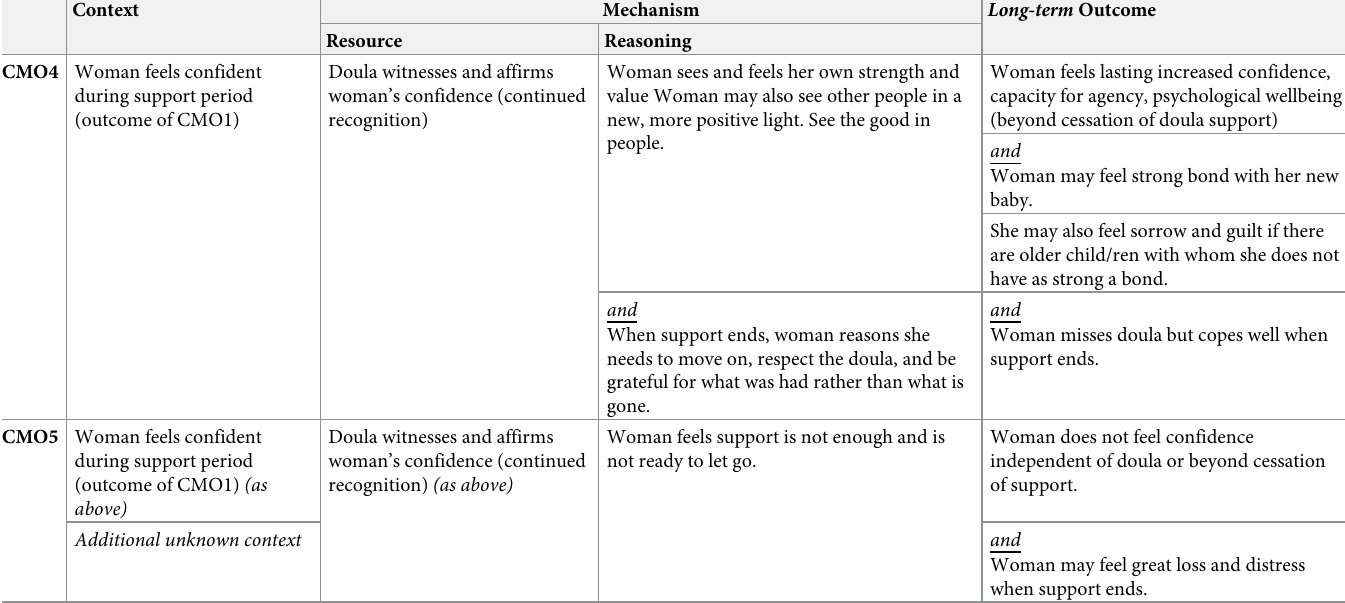
Table 7. CMO configurations 4 and 5, explaining sustained confidence-related change (or